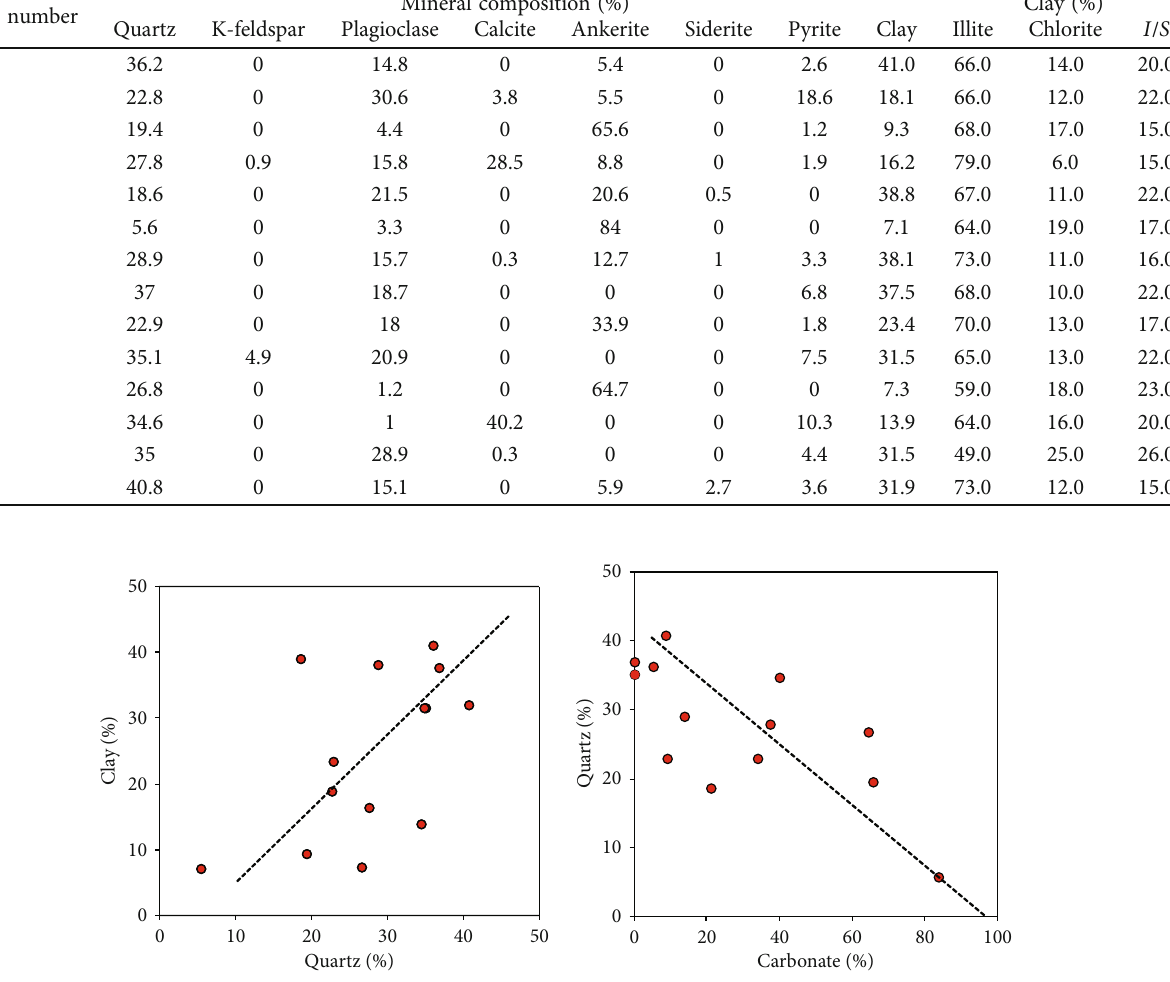
qn Formation. 2 1